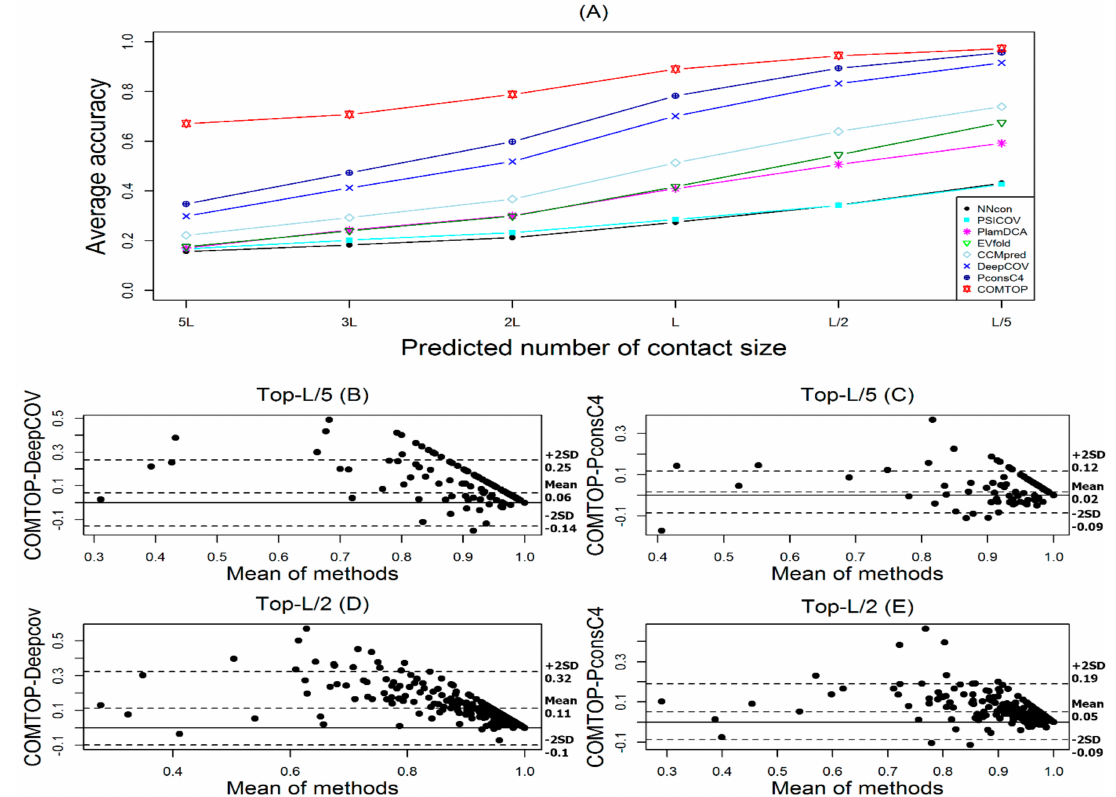
Figure 3. The overall performance of the COMTOP model. ( A ): the prediction accuracy of COMTOP with seven individual methods against predicted number of protein contacts for 239 proteins test dataset. ( B , D ): Bland–Altman plots between COMTOP and DeepCov, with the representation of the limits of agreement (dotted line), from +2SD to − 2SD. ( C , E ): Bland– Altman plots between COMTOP and PconsC4, with the representation of the limits of agreement (dotted line), from +2SD to − 2SD.